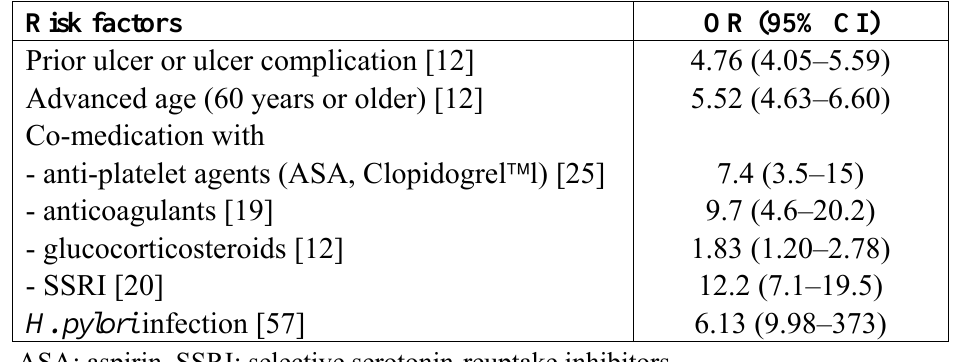
Table 2. Risk Factors for NSAID-associated gastroduodenal